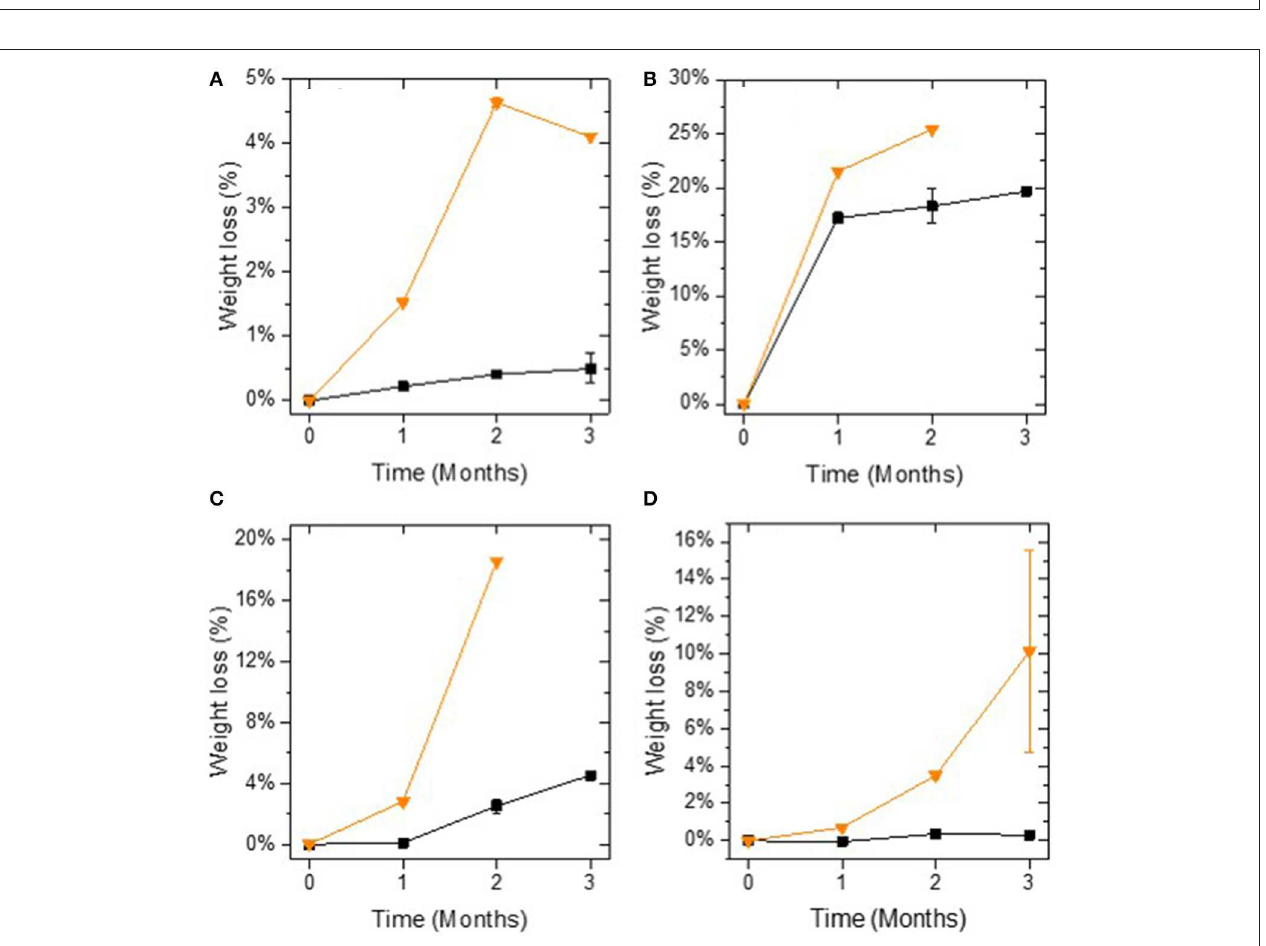
FIGURE 6 | Weight loss (%) of poly(butylene succinate) (PBS)/poly(lactic acid) (PLA) (60:40) wt phr (black) and PBS/PLA/deep eutectic solvents (DES) (60:40:1) wt phr (orange) in deionized water at 58 ◦ C (A) , in 0.01M NaOH solution at 58 ◦ C (B) , under composting conditions at 58 ◦ C (C) , and under soil burial conditions at room temperature (D) . Results are given with standard deviation. If not shown, only one sample could be recovered and weighted.